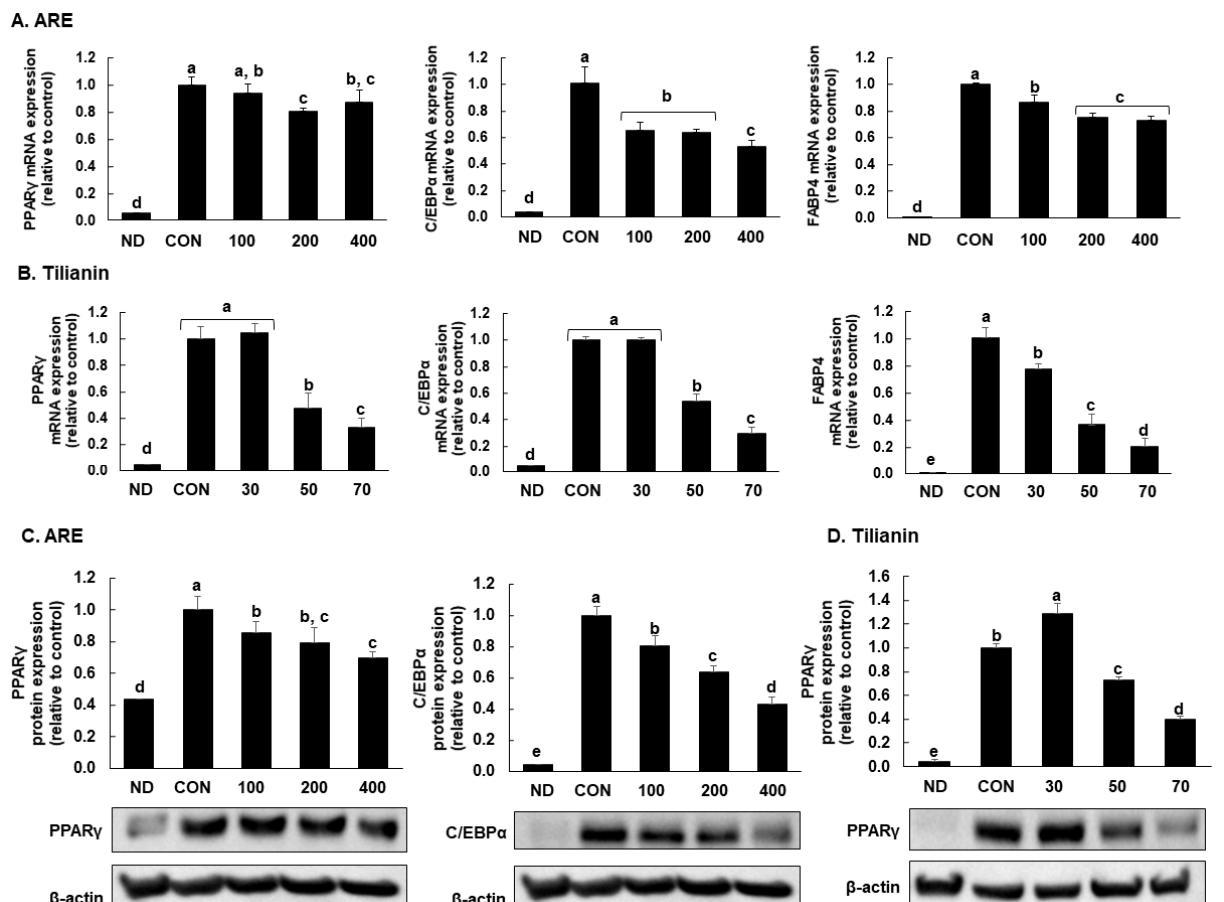
Figure 4. Anti-adipogenic effect of ARE and tilianin on mRNA and protein level of 3T3-L1 cells. ( A ). ARE-treated mRNA expression data (n = 3); ( B ). tilianin-treated mRNA expression data (n = 4). ( C ). ARE-treated protein expression data (n = 3). ( D ). Tilianin-treated protein expression data (n = 3). Different letters (a–e) in each graph indicate significantly different values in samples ( p < 0.05, ANOVA Duncan’s test).